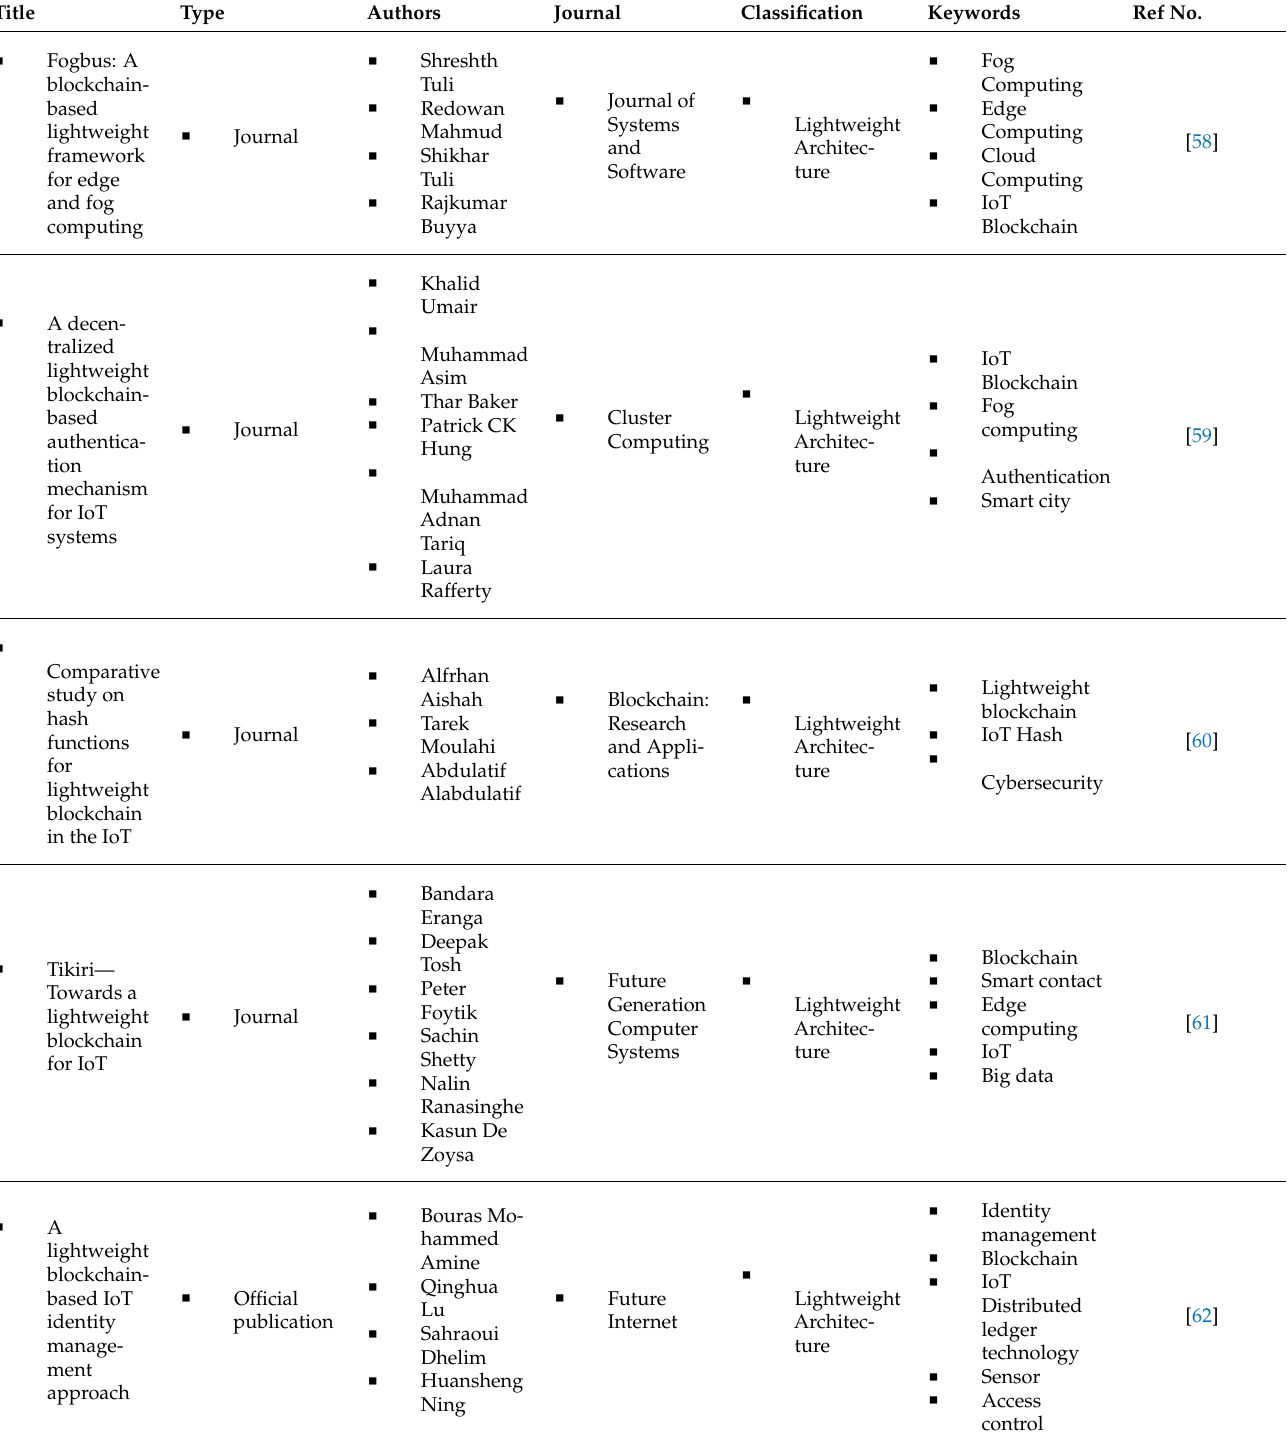
Table 3. Selected Articles.